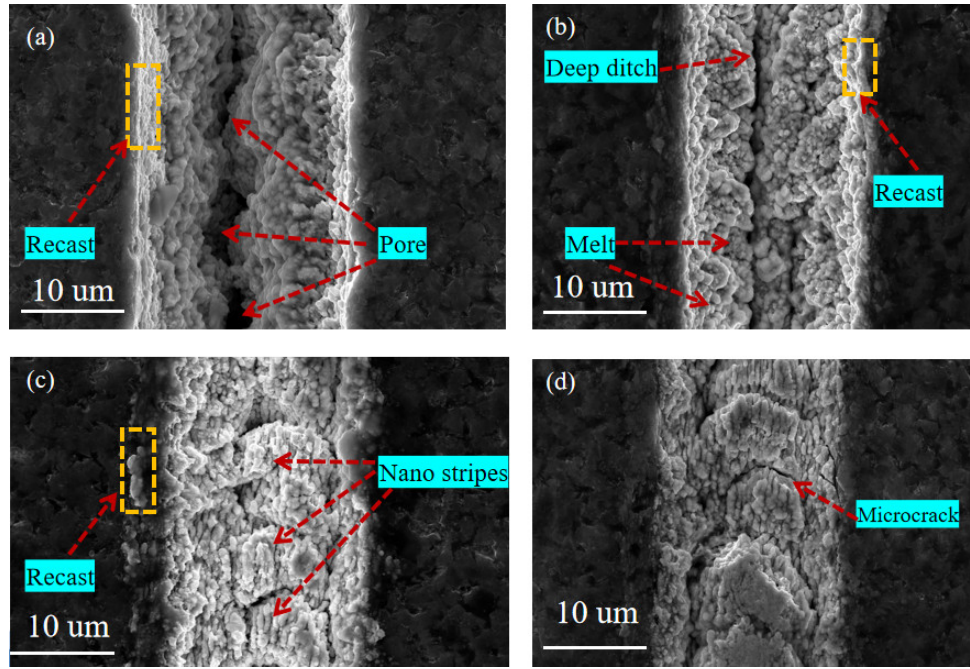
Figure 8. SEM images of micro-texture morphology under different scanning speeds. ( a ) = 0.3 mm/s, ( b ) = 0.7 mm/s, ( c ) = 1.5 mm/s, ( d ) = 2.0 mm/s). ( b ) = 0.7 mm/s, ( c ) = 1.5 mm/s, ( d ) = 2.0